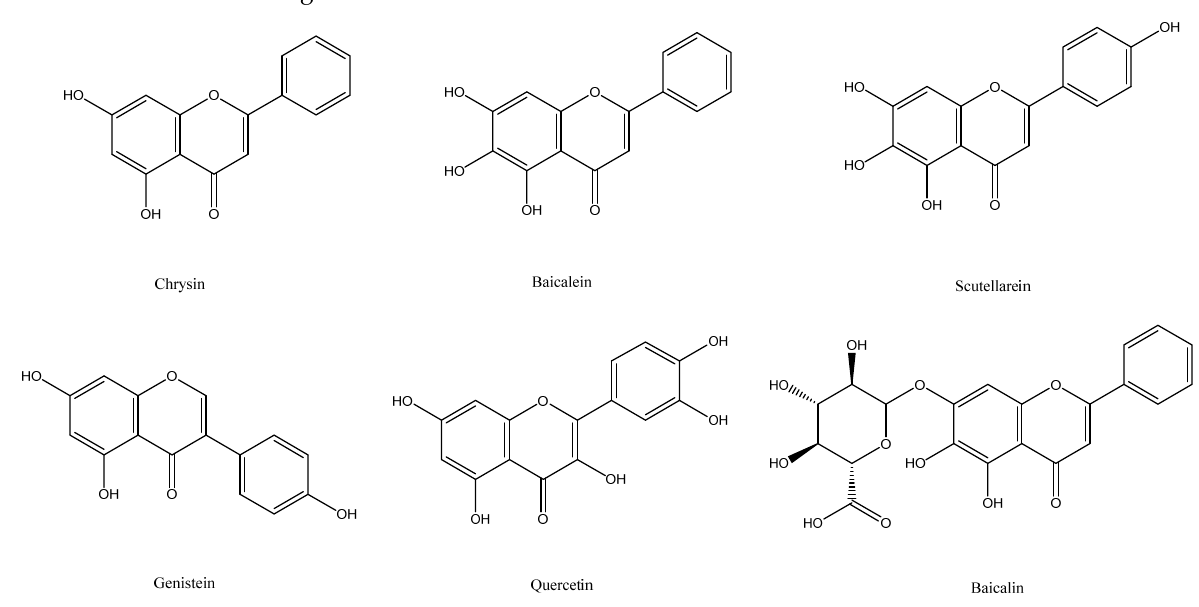
Figure 1. Chemical structure formula of the active molecule. Figure 1 . Chemical structure formula of the active molecule.